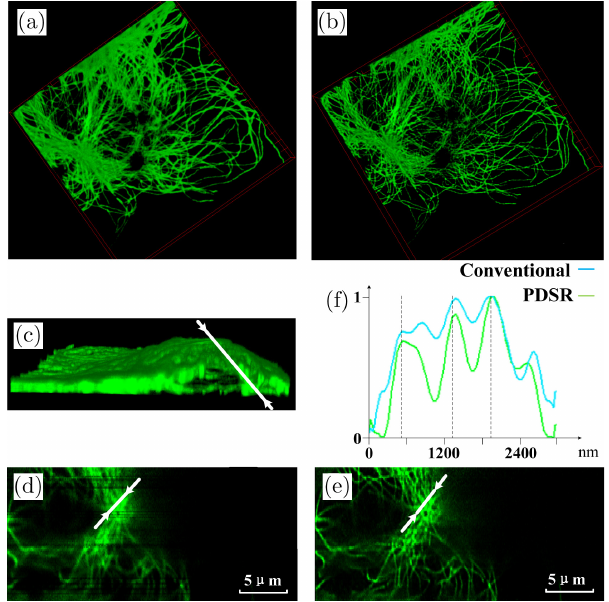
Fig. 5. The 3D image of a ¯xed U2OS cell captured by con- ventional confocal microscopy and PDSR microscopy. The top view of conventional confocal microscopy (a) and PDSR micros- copy (b). The front side image (c) of (a). The oblique images (d, e) along the direction of white line indicated in c is, respectively, extracted from (a) and (b). The line pro¯les (f) along the trace indicated by the white line in (d) and (e). Scale bar: 5 (cid:1) m.